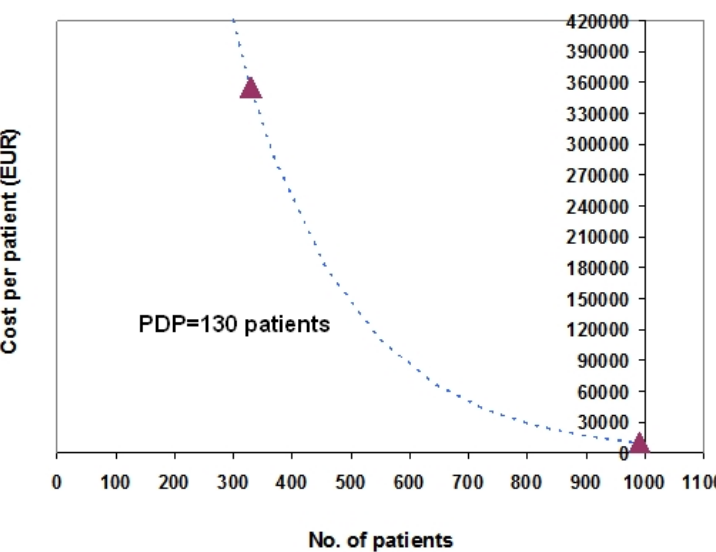
Figure 2. Price-vs.-patients relationship for orphan drugs. On the basis of a model assuming PDP = 130 patients (dotted line in blue), the graph shows the fitting procedure (two-point estimation) that allowed us to estimate PDP from the y-vs.-x of data pairs for eculizumab and bosentan (triangles). Eculizumab: patients = 330; cost per patient = 355,740 EUR; bosentan: patients = 990; cost per patient = 10,491 EUR. The mathematical calculations for estimating PDP are described in Appendix 1. Other assumptions: fPRICE = 10,000 EUR.